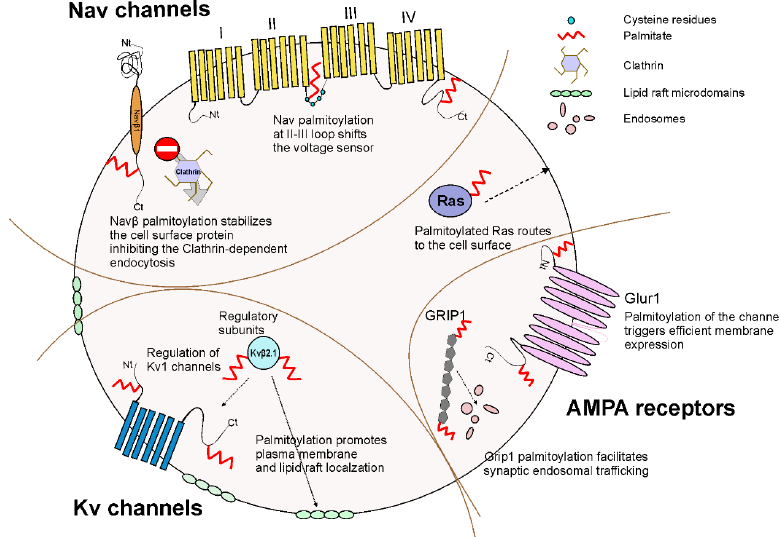
Figure 2. Schematic representation of multiple palmitoylation effects on VGIC and regulatory subunits. AMPA receptors are also shown. Palmitoylation may affect traffic and membrane stabilization, but it can also modulate other cellular mechanisms such as endocytosis and recycling. Alterations of the electrophysiological properties have been also documented.